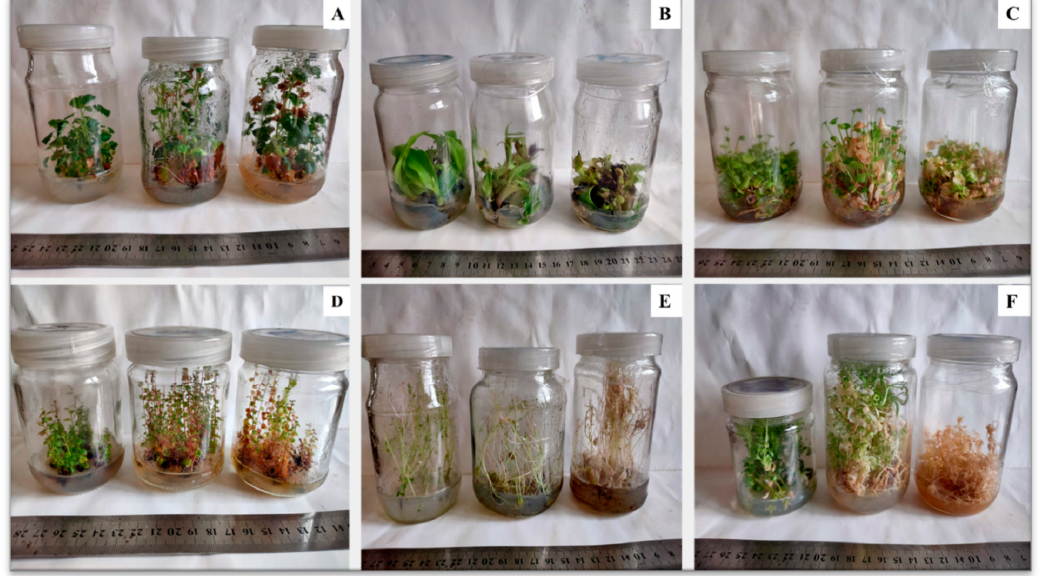
Figure 3. Effect of subculture delay on in vitro growth and shoot multiplication (in each photo, left jar = normal plant, middle jar = plant in the first stage of degradation, right jar = dead plant). Blackberry ( Rubus ulmifolius Schott) ( A ), banana (Musa sp.) ( B ), Philodendron selloum ( C ), blueberry ( Vaccinium corymbosum L.) ( D ), potato ( Solanum tuberosum L.) ( E ), and Gypsophila paniculata ( F ).